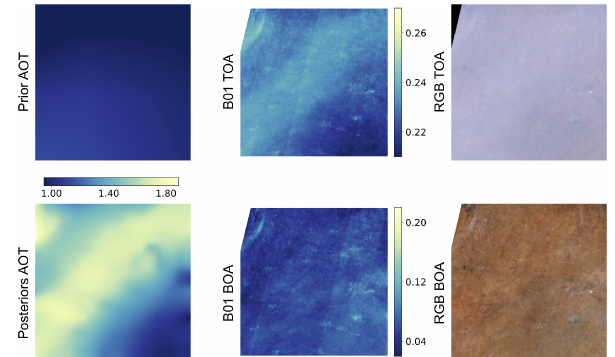
Figure F1. The prior and posterior AOT over S2 50SMH on 10 February 2016 and their shared colour bar are in the first col- umn. Figures in the second column are band 1 TOA and surface reflectance, while the TOA and BOA RGB images are shown in the third column for the same tile over the same